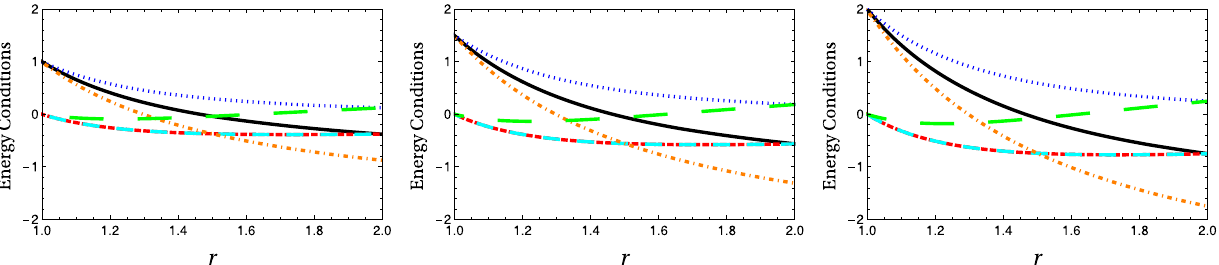
Fig. 3 Energy conditions taking as fixed values r 0 = 1 , A = 1 , n = − 1 and β = 1 for the following cases: (1) ˜ ρ ( black line), (2) ˜ ρ + ˜ p (short dashedredline),(3) ˜ ρ + ˜ p t (dottedblue line),(4) ˜ ρ −| ˜ p r | (dashed cyan line), (5) ˜ ρ − | ˜ p t | (dot-dashed orange line), and (6) ˜ ρ + ˜ p r + ˜ p t